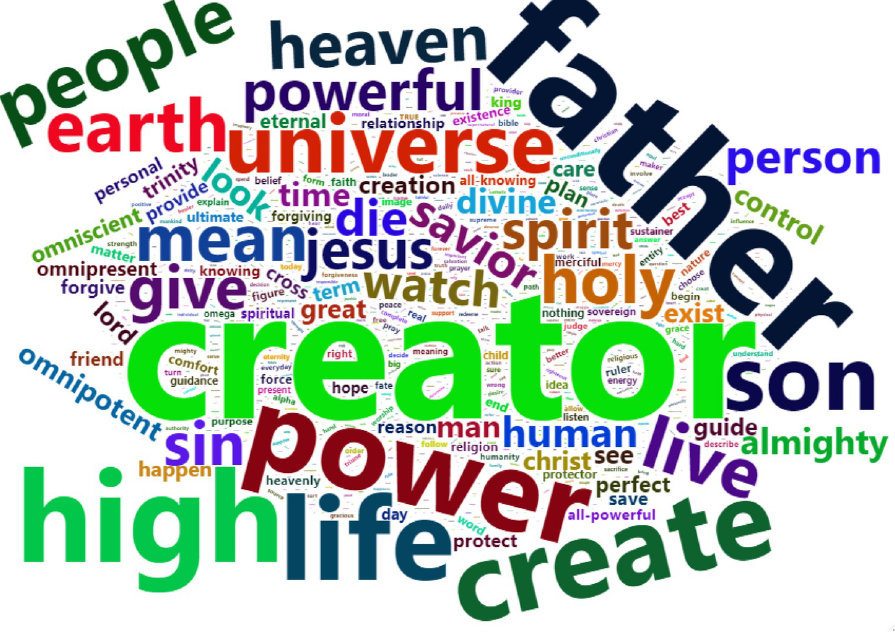
Fig 4. Word cloud of raw word frequencies with larger words being more frequent and smaller words less